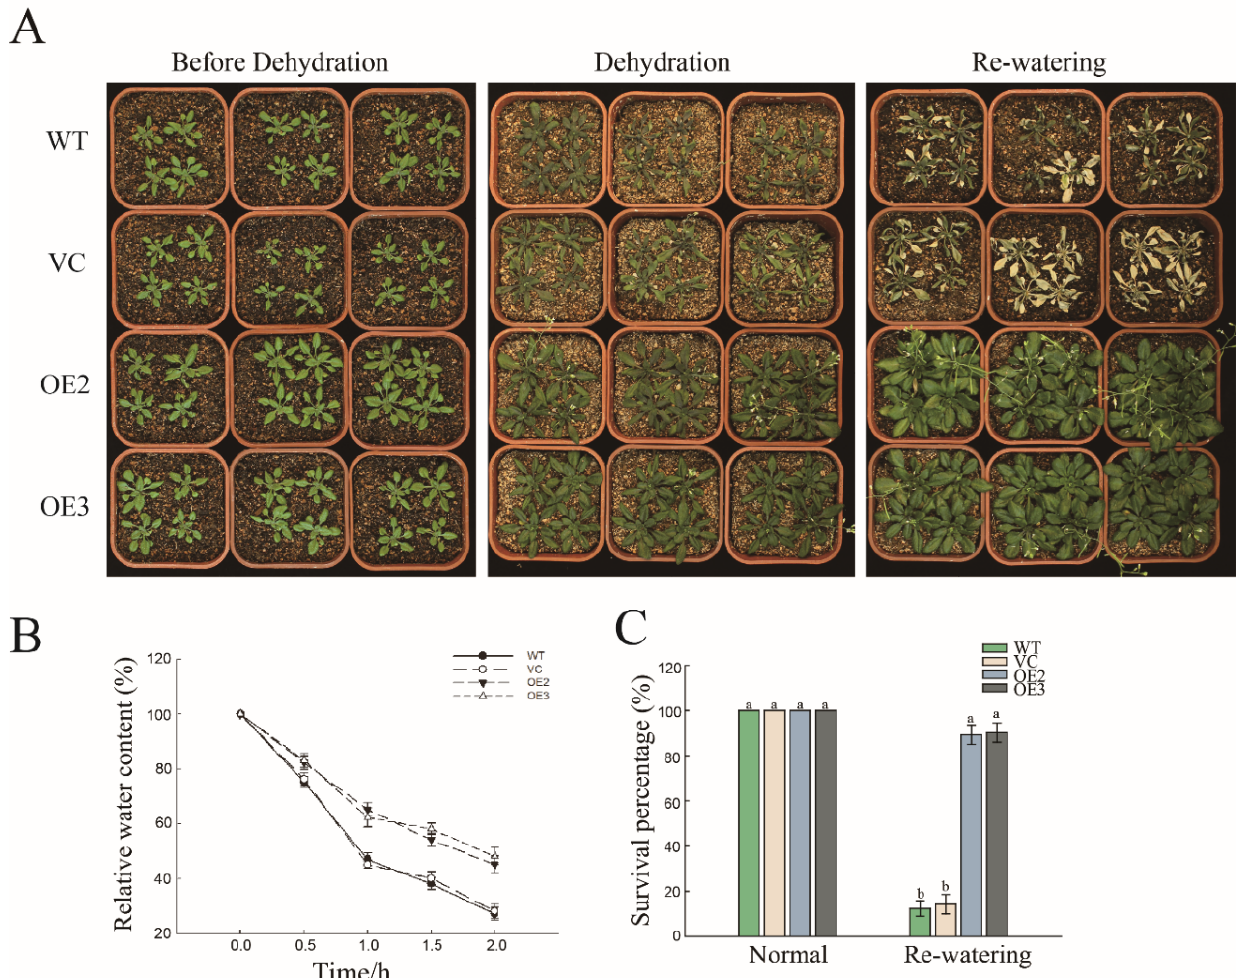
Figure 3. Overexpression of PwNAC11 improves tolerance to drought stress. ( A ) Phenotypes of different lines under drought conditions. Dehydration lasted 14 days, followed by re-watering for 3 days. ( B ) Relative Water Content (RWC) after drought stress. Isolated leaves were placed at room temperature and dehydrated for 2 h. ( C ) Survival percentage before drought treatment and after re-watering. Different letters indicate the significant differences at p < 0.05.